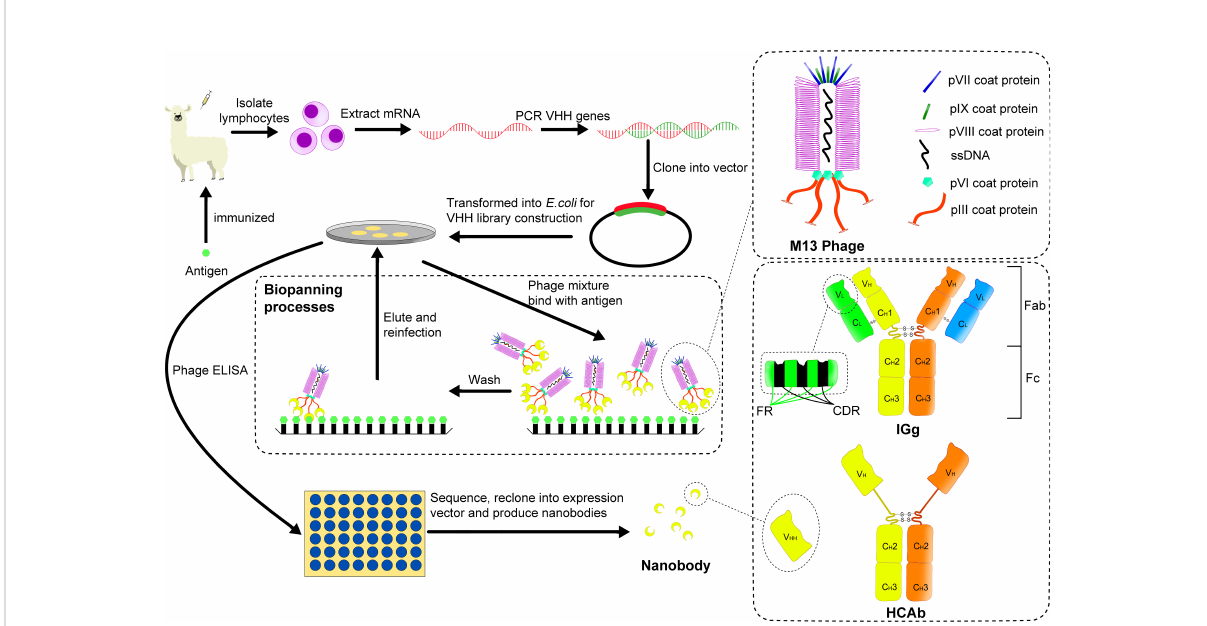
FIGURE 1 A brief process for building an immune library and screening for nanobody using M13 phage display. The coat structure of M13 phage is shown in the upper right panel, and the structure difference between general IgG and HCAb in camelids is shown in the lower right panel. After using a speci fi c antigen to immunize a camelid, mRNA is extracted from its lymphocytes. Then PCR technology is used to obtain the corresponding DNA fragments, which are cloned into a phage display vector. After several cycles of biopanning, the required phages are screened for antigen binding via ELISA. Finally, the obtained nanobodies are sequenced and expressed for example in E.coli